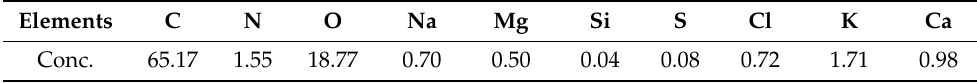
Table 2. Elemental analysis of poultry